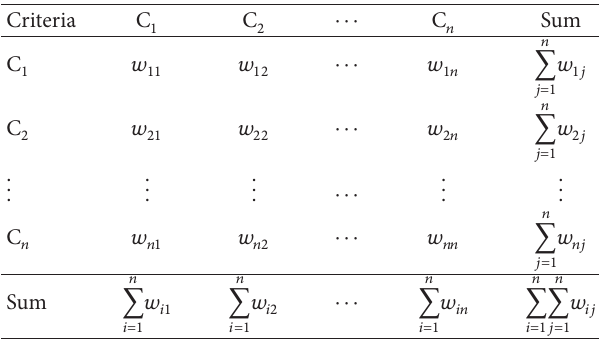
Table 2: Pair-wise comparison result of AHP.